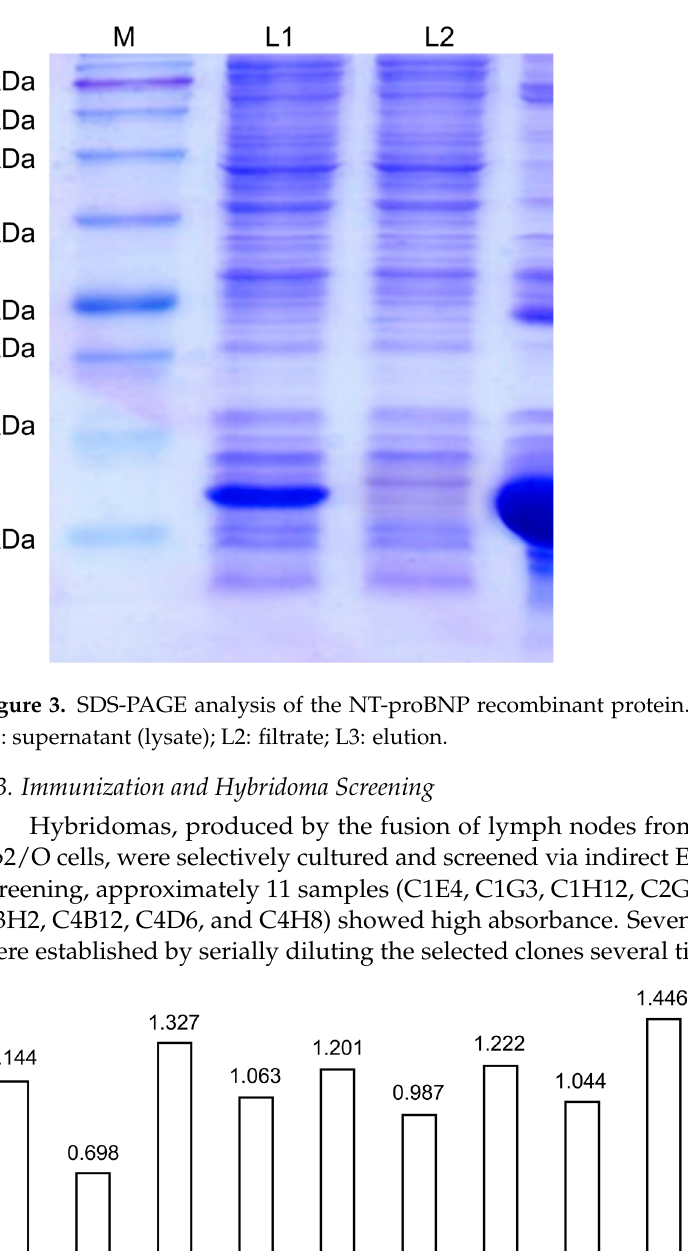
Figure 2. Agarose gel electrophoresis analysis of the NT-proBNP DNA fragment amplified via PCR. Lane M indicates the 100 bp DNA ladder. Lane L contains the PCR products of NT-proBNP. The approximate size of the amplified DNA fragment was 228 bp.